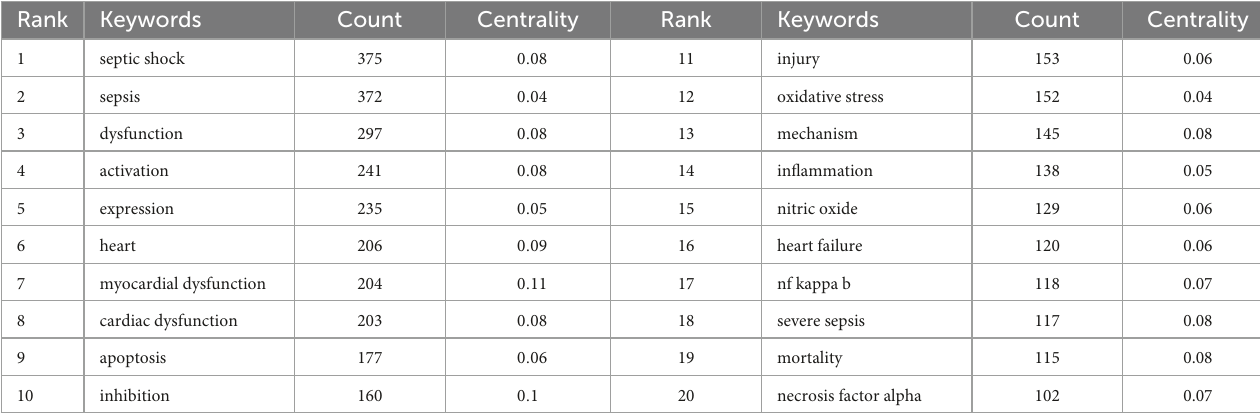
TABLE 5 The top 20 keywords related to